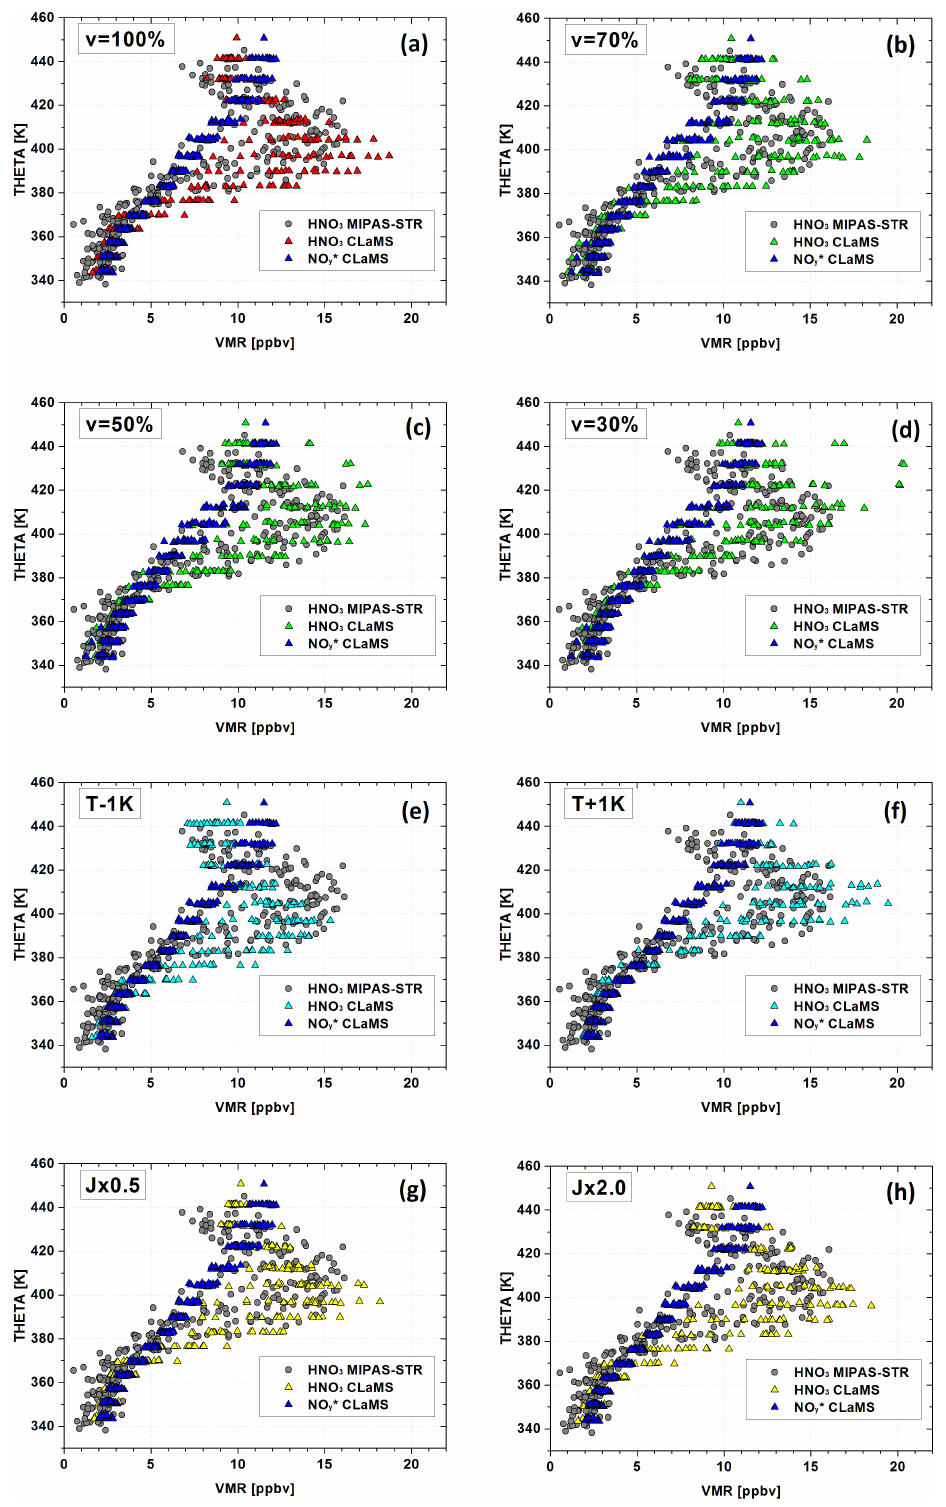
Figure 13. Same comparison as in Fig. 12 but for the flight on 30 January 2010 under conditions free of PSCs.